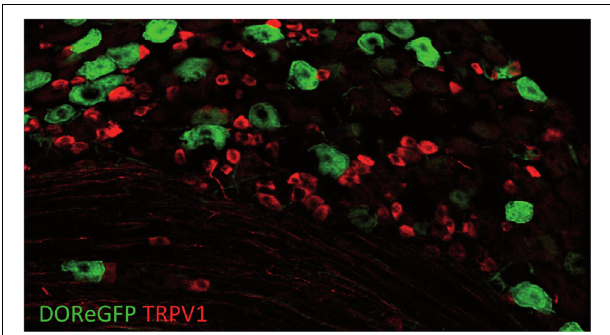
FIGURE 5 | Delta opioid receptor (DOR-eGFP mice, green) rarely overlaps with TRPV1 (red). Image courtesy of Grégory Scherrer, Stanford